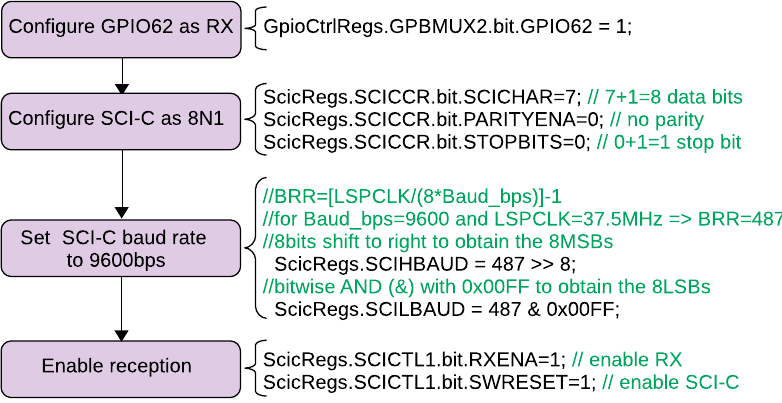
Figure 8. Initialization procedure for SCI-C (using the ControlSuite